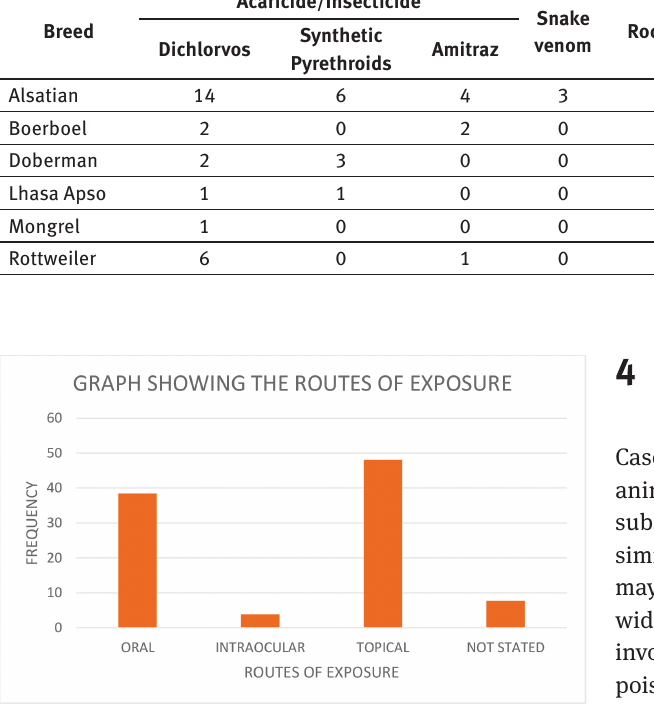
Table 1 The causes of poisoning in different dog breeds presented to the Veterinary Teaching Hospital, Federal University of Agriculture, Abeokuta, Ogun State, Nigeria with suspected cases of poisoning